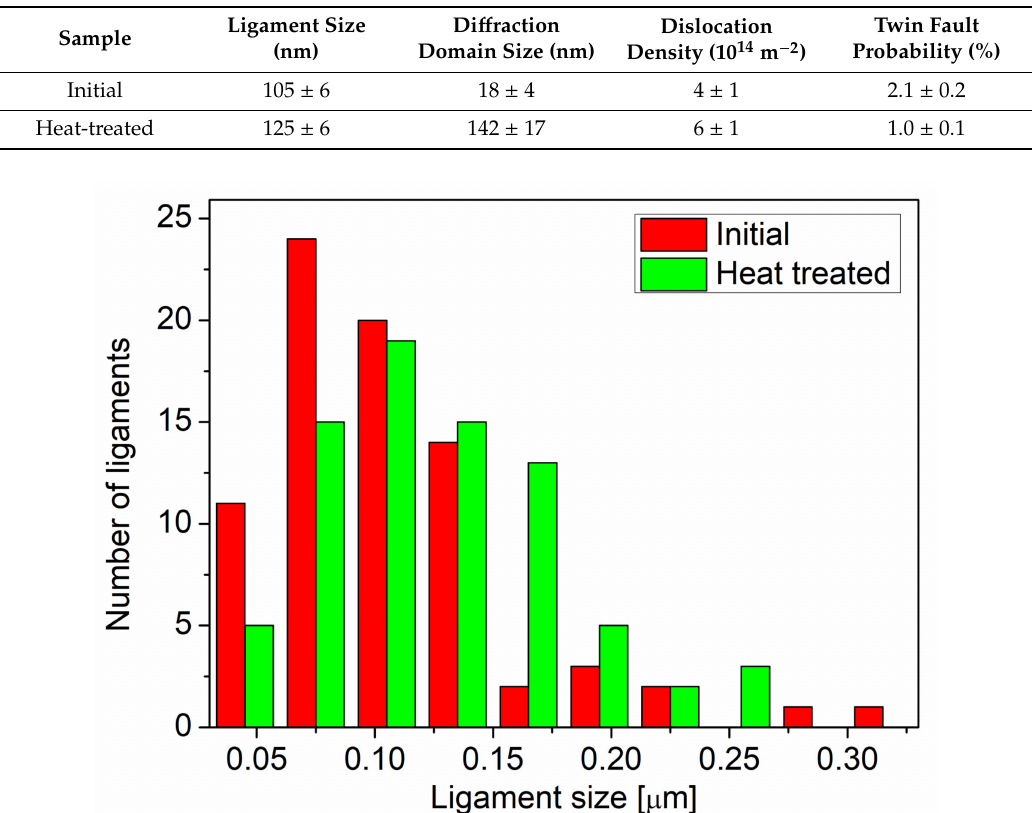
Figure 4. Ligament size distribution in the initial (red) and the heat treated (green) Cu